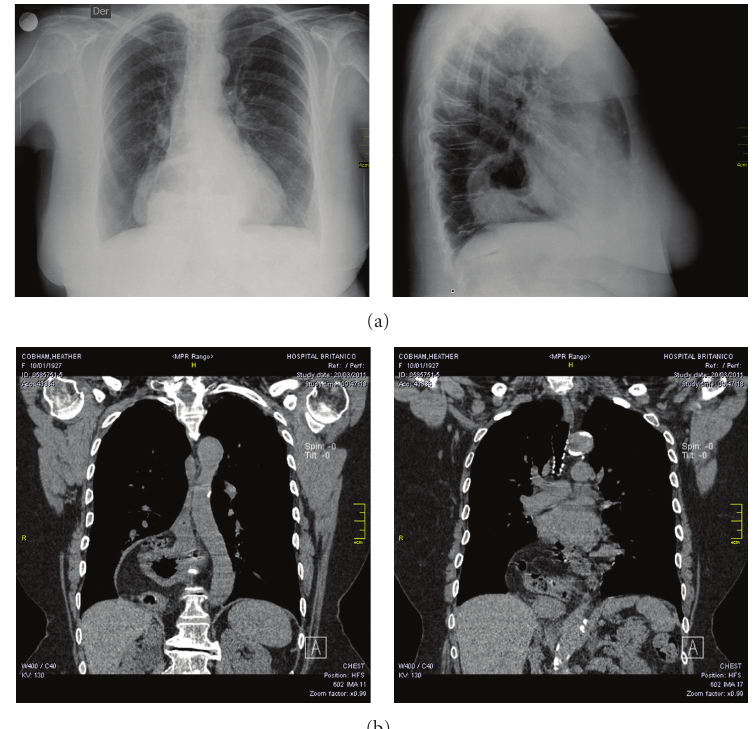
Figure 1: (a) A large retrocardiac opacity is observed with air and liquid level compatible with a giant hiatus hernia. (b) A CT-scan with reconstruction is shown validating the diagnosis. The mass corresponding to the stomach and likely small bowel is located behind the heart and in close relation to the left